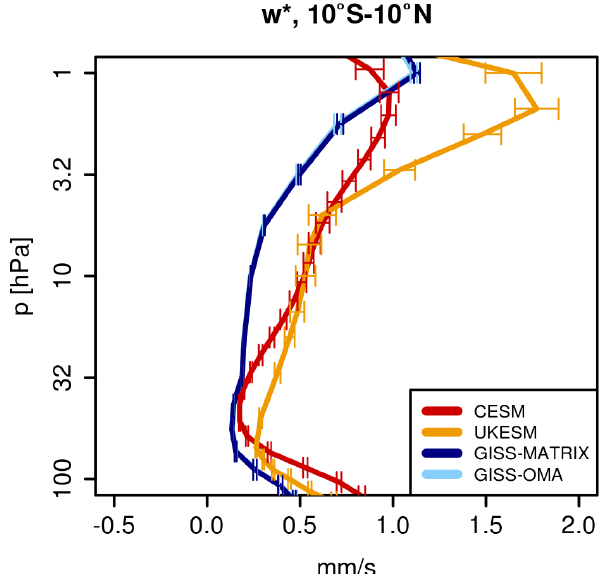
Figure 4. Climatological transformed vertical residual velocity av- eraged over 2035–2064 and 10 ◦ S–10 ◦ N in the control SSP2–4.5 for each of the four models. Error bars denote ± 2 standard error of the